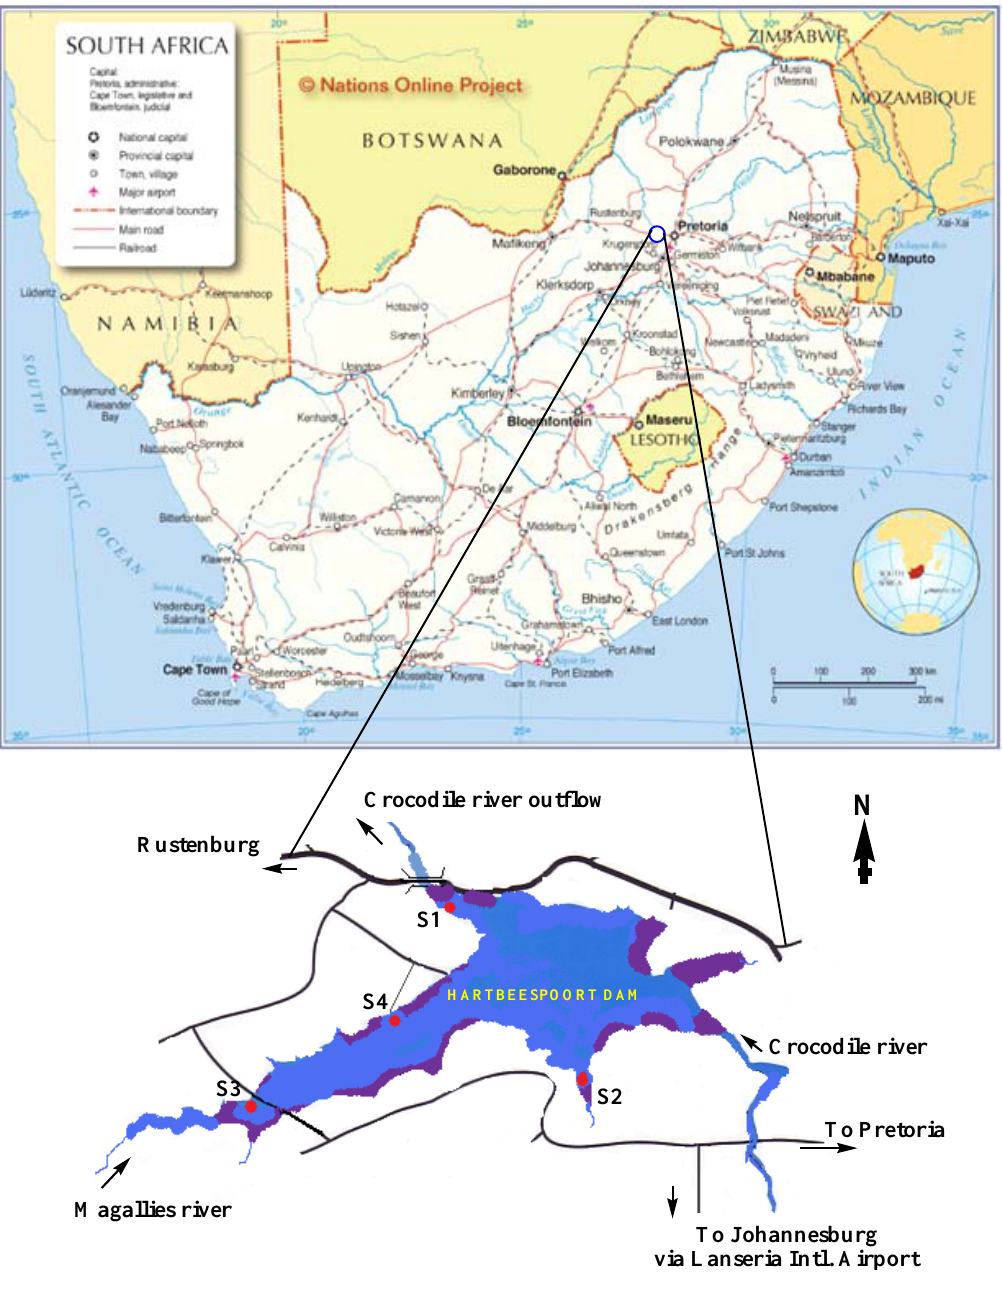
Figure 1. Map and GPS co-ordinates showing sampling sites on the Hartbeespoort (HBP) dam. S1: ( − 25°43'38.76"S, +27°50'57.21"E), S2: ( − 25°46'14.09"S, +27°51'57.85"), S3: ( − 25°45'37.71"S, Conservation/or restricted areas in the dam are marked with purple colour (source: African & South African maps: Nations Online Project available at www.nationsonline.org/